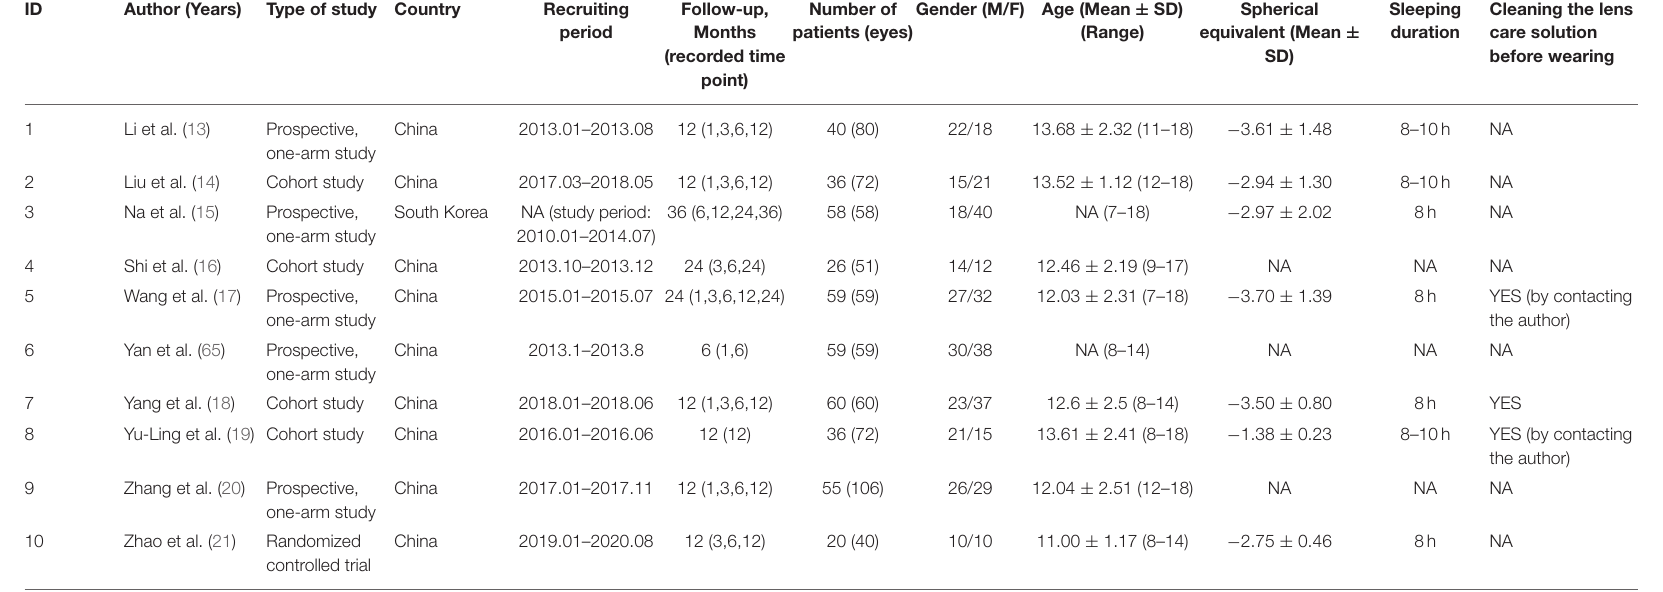
TABLE 1 | Characteristic of the included studies in the